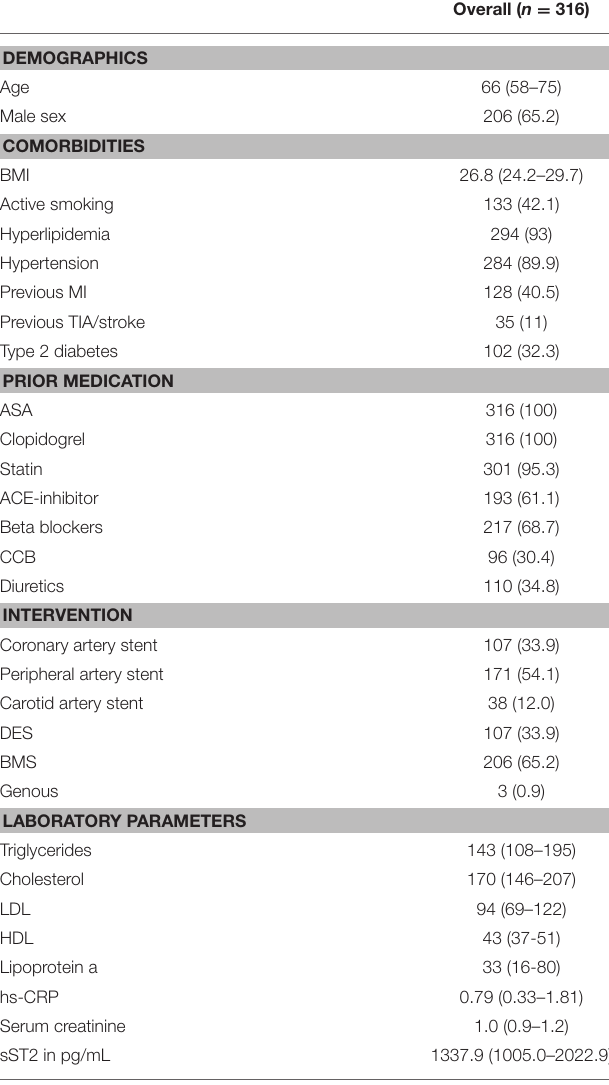
TABLE 1 | Baseline clinical characteristics of the patient